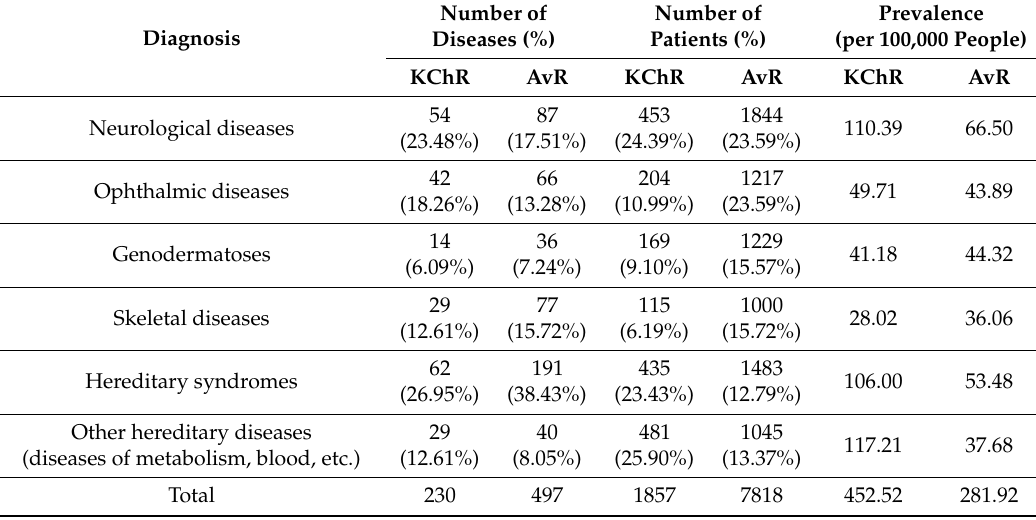
Table 1. Structure of diversity and occurrence of hereditary diseases (HDs) divided by the main nosologic groups found in Karachay-Cherkess Republic (KChR) compared to the other populations of